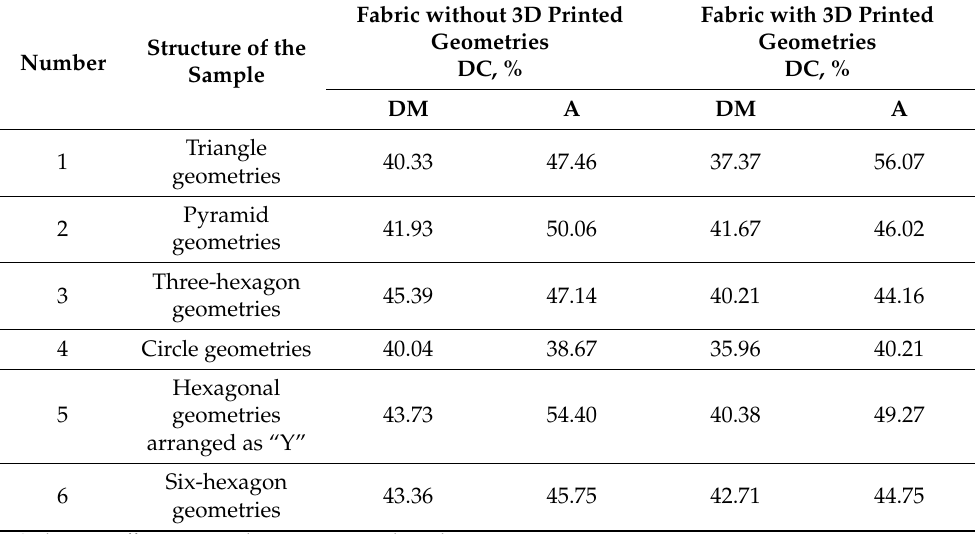
Table 5. Comparative analysis of drape coefficient (DC, %) measurement methods.